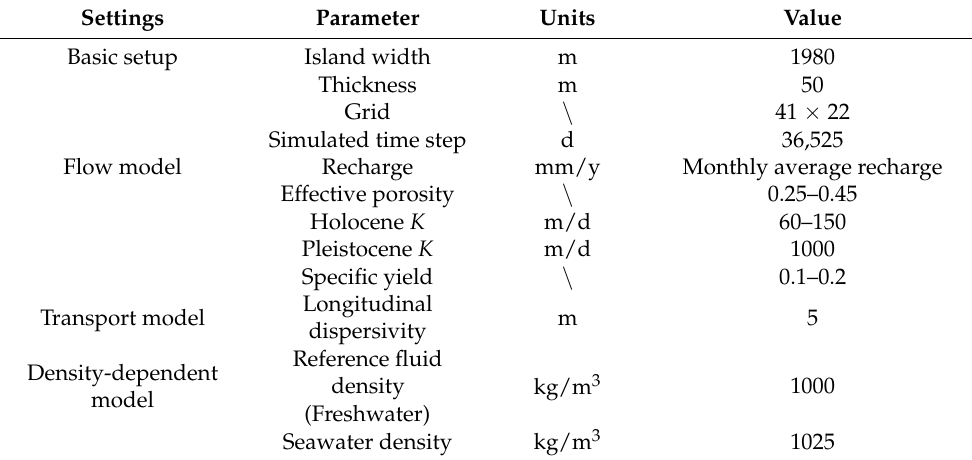
Table 1. Parameter values used in the model for the coral island groundwater system.